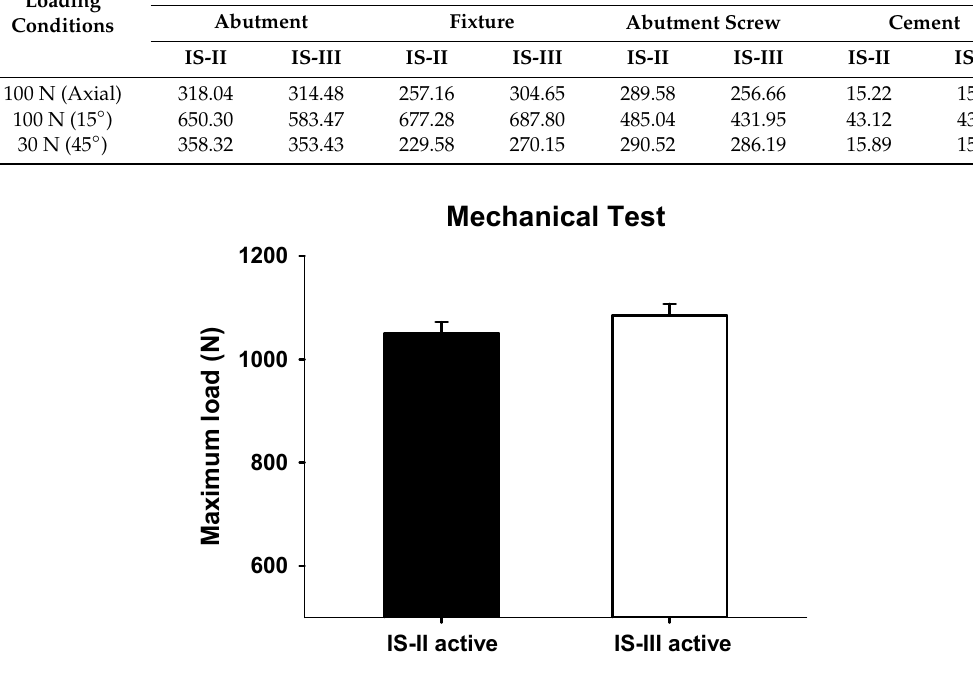
Figure 8. Maximum loads (N) of IS-II and IS-III.